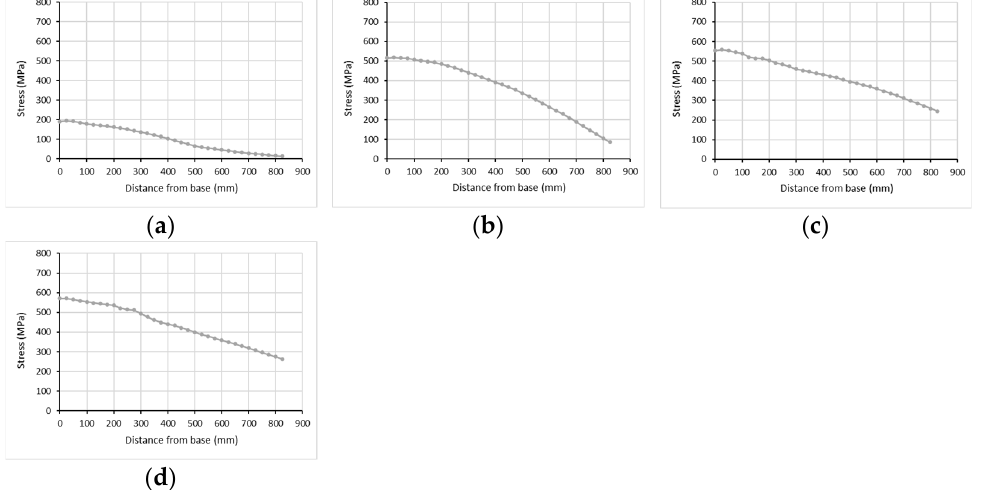
Figure 11. Developed stress along starter longitudinal bars in tension at a displacement of ( a ) 3.39 mm, ( b ) 9.74 mm ( δ y ), ( c ) 23.88 mm ( δ Pmax ) and ( d ) 36.86 mm ( δ u ), for column